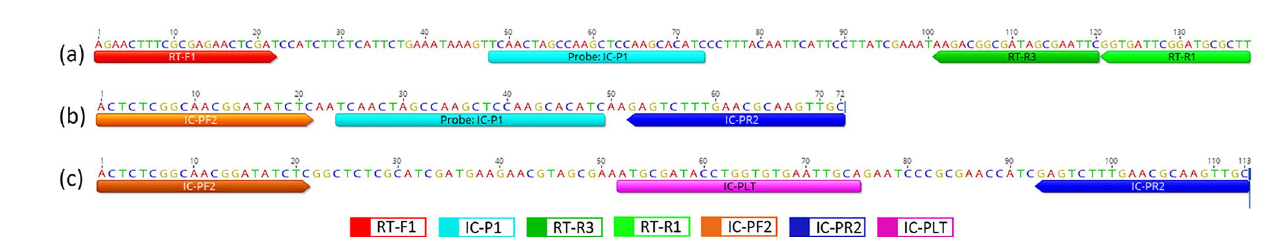
Figure 6. Internal control target regions and design – both AIC-1 and AIC-2 were artificially synthesized. ( a ) Artificial internal control AIC-1 contains target for primer RT-F1, RT-R1, RT-R3 and a unique probe IC-P1; ( b ) artificial internal control AIC-2 contains target for primer IC-PF2, IC-PR2 and a unique probe IC-P1; ( c ) host internal control HIC is an internal transcribed spacer sequence of host genome ( Lolium rigidum ) contains target for primers IC-PF2, IC-PR2 and probe IC-PLT. AIC-1 can be detected by using the same primer as for R. toxicus —no need to add another set of primer but require an additional unique probe to be detected by different channel of qPCR. AIC-2 can be detected by using the same primer set as to detect host genome—no need to add any additional primer set to detect AIC-2 but require an additional unique probe to be detected by different qPCR channel. An additional primer and probe is required for